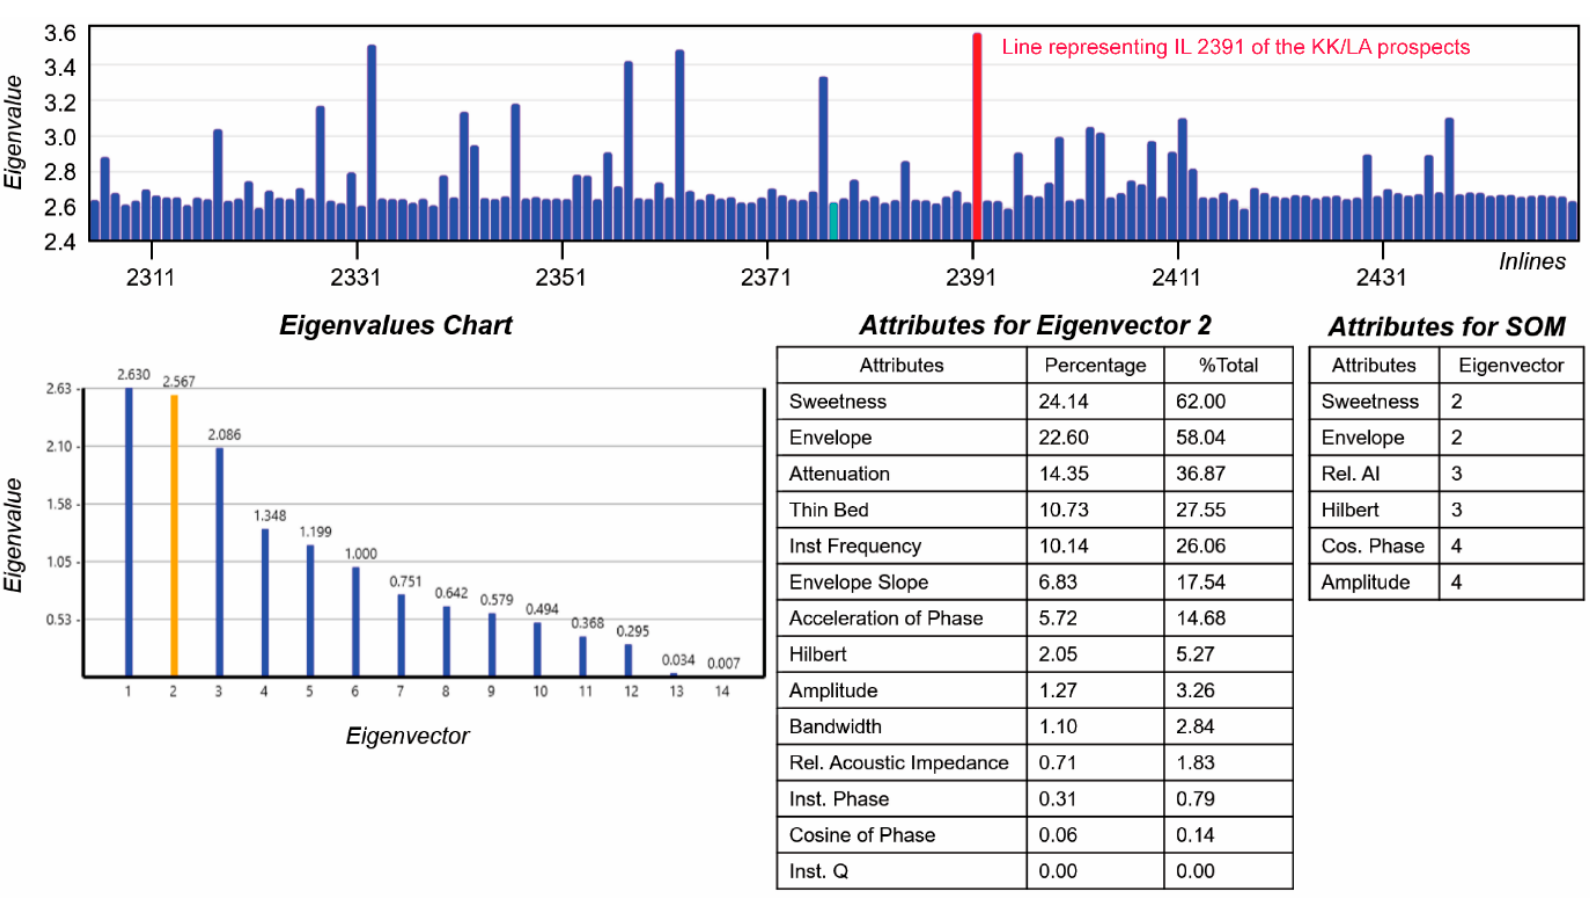
Figure 7. PCA results for Inline 2391 (shown in Figure 3) of the KK/LA 3D seismic survey. The highest-ranking attributes from the first few eigenvectors were chosen to be incorporated into the SOM analysis over the entire dataset. These attributes were envelope, Hilbert, the cosine of instantaneous phase, relative acoustic impedance, and sweetness. These attributes were also combined with the full-stack amplitude.